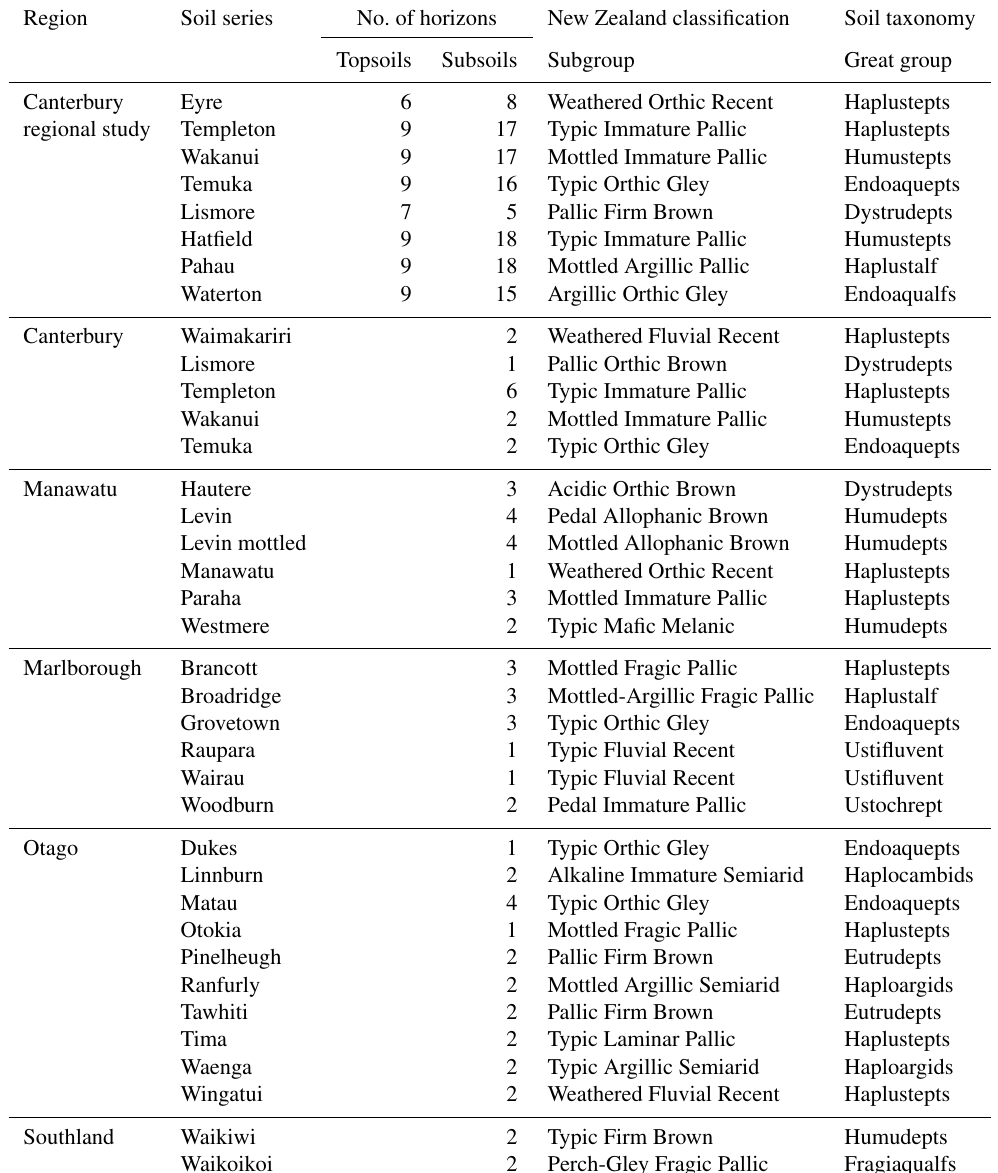
Table 4. Soil series and classification.